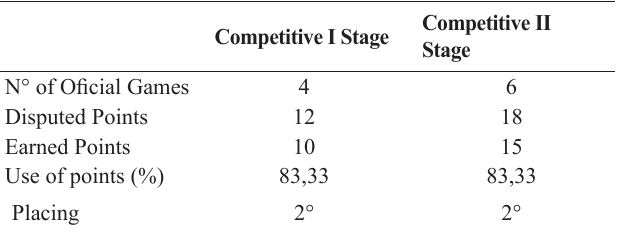
Table 4. Match performance in the competition during the stages of the